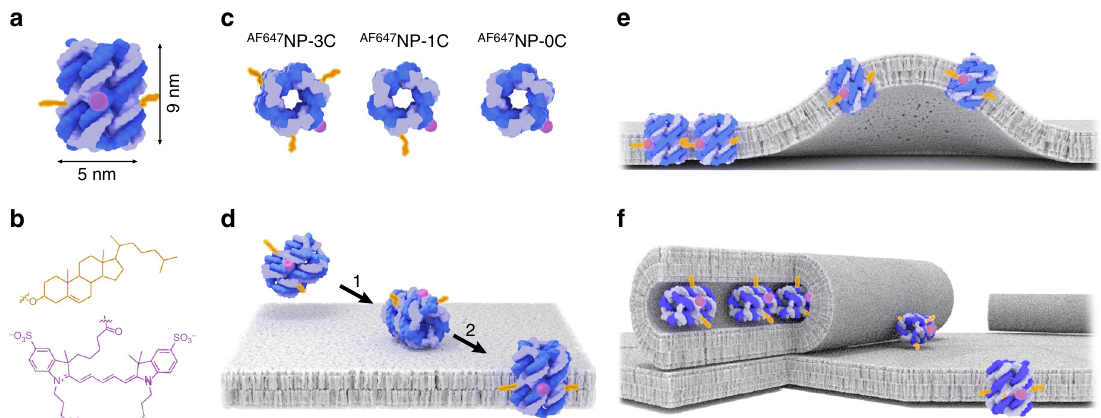
Fig. 1 Structural and functional architecture of the DNA nanopores. a Side-view and external dimensions of NP-3C carrying three cholesterol anchors (orange) and the fl uorophore Alexa Fluor 647 (AF647 - purple). b Chemical structure of cholesterol moieties (orange) for binding and insertion into membranes, and the Alexa Fluor 647 fl uorophore (purple) used for detecting individual pores in the membranes. c Top-down view of NP-3C, NP-1C, and NP-0C with 3, 1, and no cholesterol anchors, respectively. d − f Mechanisms of DNA NP insertion, clustering and membrane-reshaping identi fi ed in this study. d Anticipated two-step integration of NP-3C into a lipid bilayer. e Formation of dynamic NP-3C clusters and enrichment in curved membrane structures. f Proposed model for the NP-3C-induced formation of lipid nanotubes with luminally attached pores in case of excess lipid on the membrane surface. For reasons of visual simplicity, d - f do not account for the reorganization of the lipids at the interface to the NPs. Lipids are likely re-oriented to position the polar head-group closer to those DNA segments that do not carry a cholesterol anchor